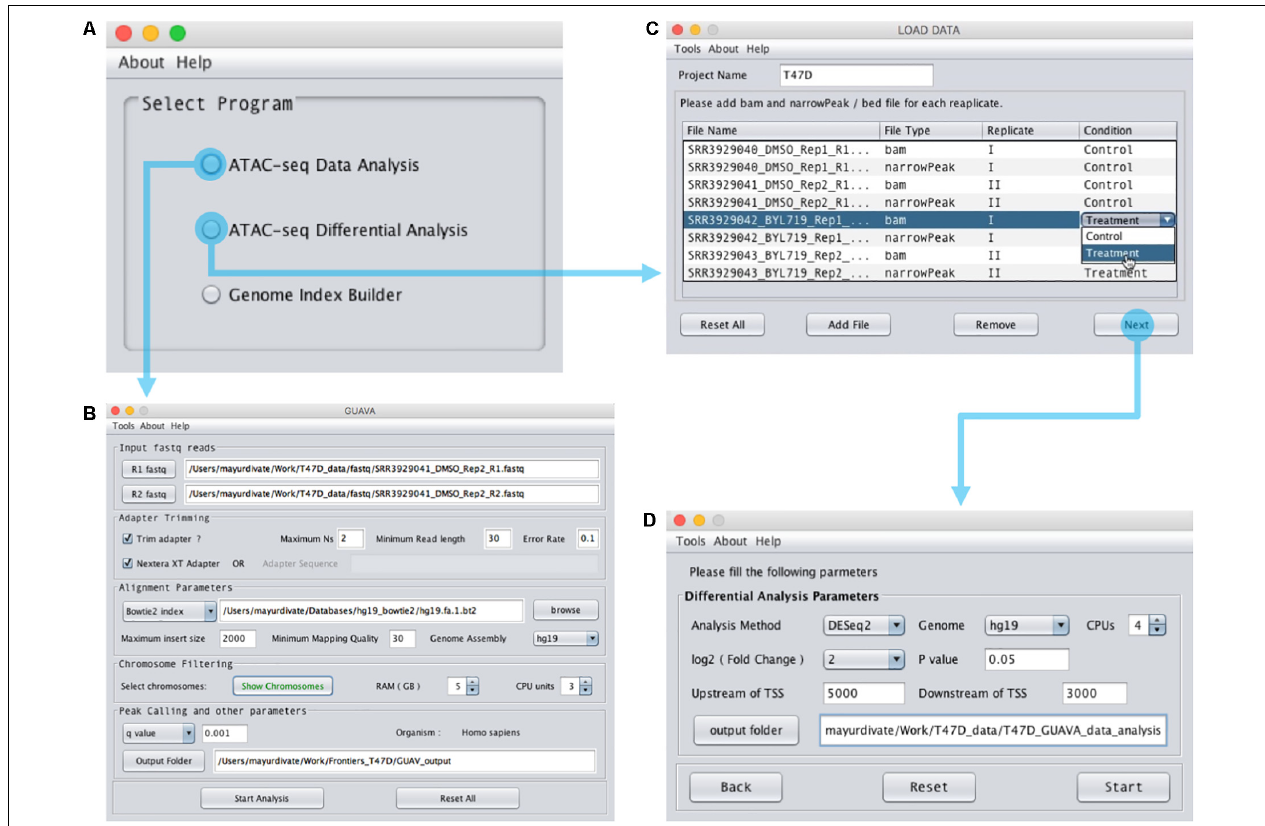
FIGURE 2 | Design of the GUAVA input interface. (A) The main GUAVA window where users select the program they wish to use (ATAC-seq data analysis or ATAC-seq differential analysis). (B) Window for using ATAC-seq data analysis. To perform ATAC-seq data analysis, users load the sequencing data using the R1 fastq and R2 fastq buttons. Next, they choose between Bowtie and Bowtie2 from the drop-down menu in the “Alignment Parameters” section. If required, users can change the other parameters from the default value to another value. For example, the default RAM used for GUAVA is 1 GB but it can be changed if desired. Finally, to run the analysis users simply click the “Start Analysis” button. (C) Window for using ATAC-seq differential analysis. To perform ATAC-seq differential analysis, users set the project name, load the bam and bed files and then set the differential analysis parameters in (D) before selecting the “Start”